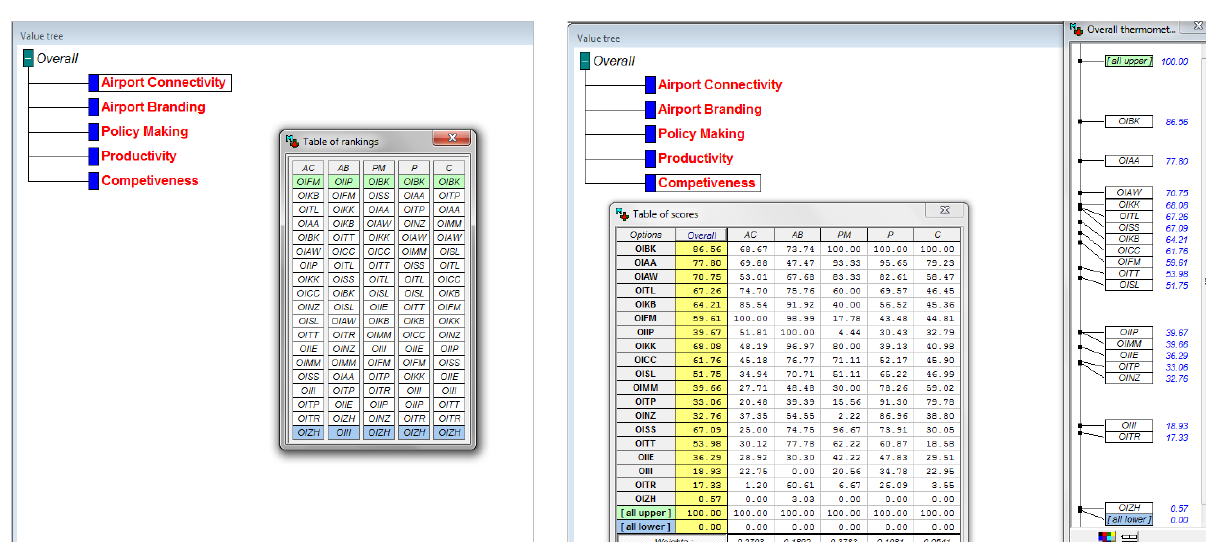
Figure 5. Overall calculations of alternatives’